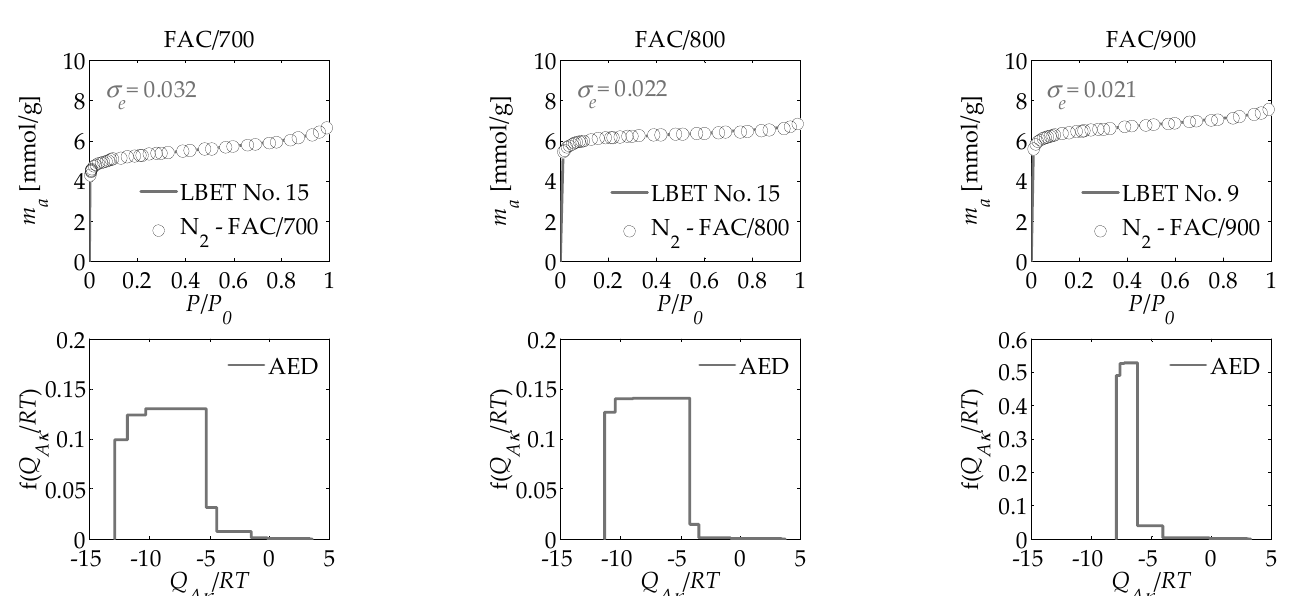
Figure 3. Nitrogen adsorption isotherms for activated carbons derived from the leaves of common polypody and the fast multivariant identification procedure results obtained via the LBET method; where AED is the adsorption energy distribution for the first adsorbed layer.